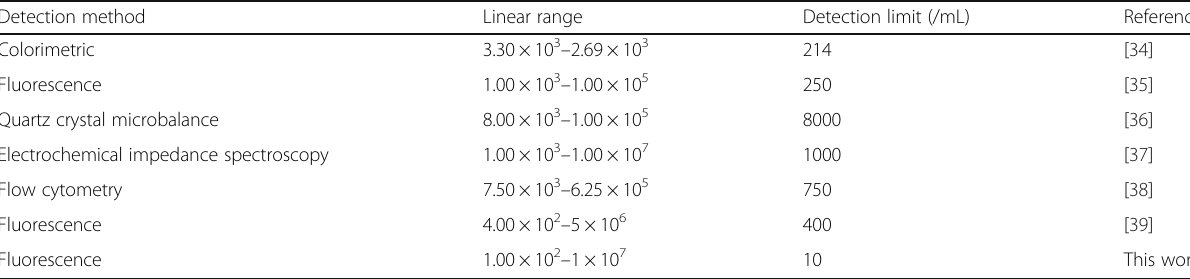
Table 1 Comparison of analytical properties for CCRF-CEM cytosensors Detection method